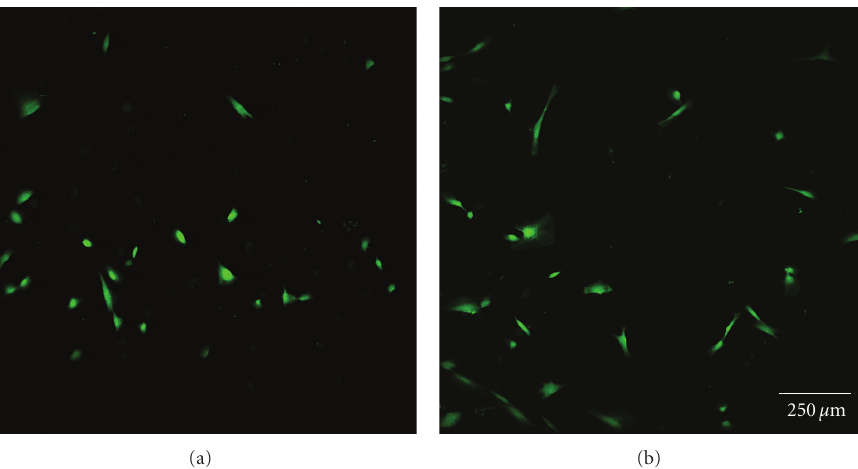
Figure 6: Fibroblast cells cultured on glass discs coated with hexylated polymer and spin coated with nanoporous silicon dioxide after 24 h (a) and 72h (b).